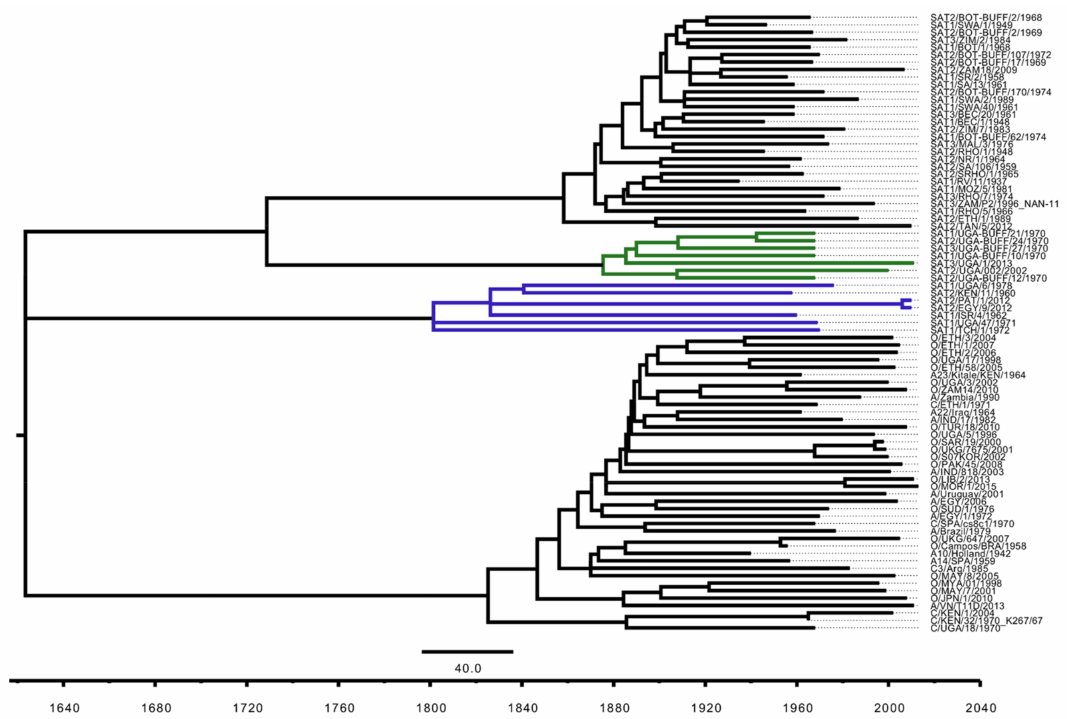
Figure 5. Divergence time estimates for the QENP and uEA clades. The ML tree was based on nucleotide sequence spanning through 2B and 2C encoding regions (i.e., region equivalent to 3995–4651 nucleotide position of the A/Brazil/79 (AY593788.1) sequence) and was estimated using RAxML 8.2.11 with a bootstrap search of 1000 iterations by majority-rule tree based criteria and GTR + G + I substitution model. Molecular-clock phylogeny was inferred using TreeTime 0.94 and the final tree was visualized and colour-coded in FigTree v1.4.3. Branches leading to the taxa forming QENP and uEA clades are highlighted in dark green and blue, respectively. Taxa names contain full year